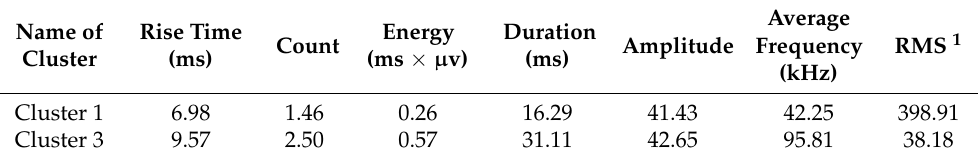
Table 3. Average AE parameters of cluster 1 and cluster 3.